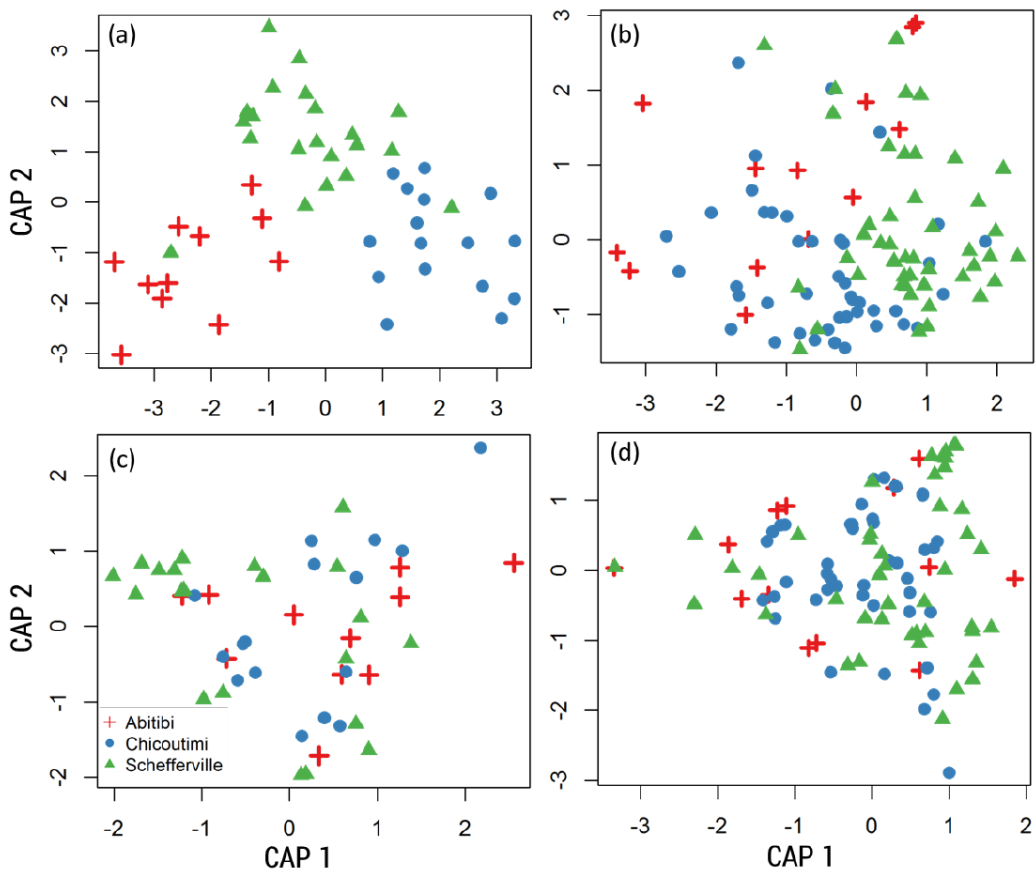
Figure 4: Two-dimensional scatter plot of canonical axes of the CAP ordinations for (a) phytoplankton and (b) zooplankton taxonomic composition and their respective functional trait compositions (c, d). Symbols represent the different regions. Strong regional differences occurred for taxonomic composition of phytoplankton (a, p=0.01) and zooplankton (b, p=0.01), but were not significant for functional trait composition (c and